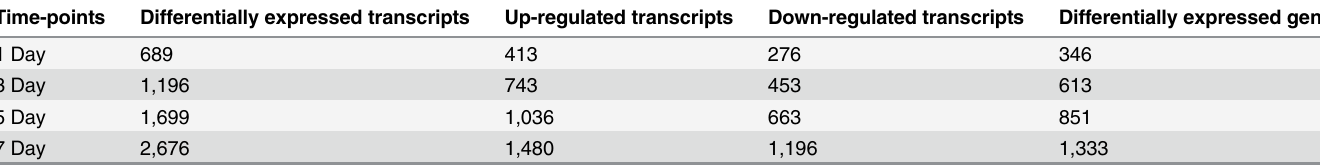
Table 2. The numbers of significant differentially expressed transcripts and genes.